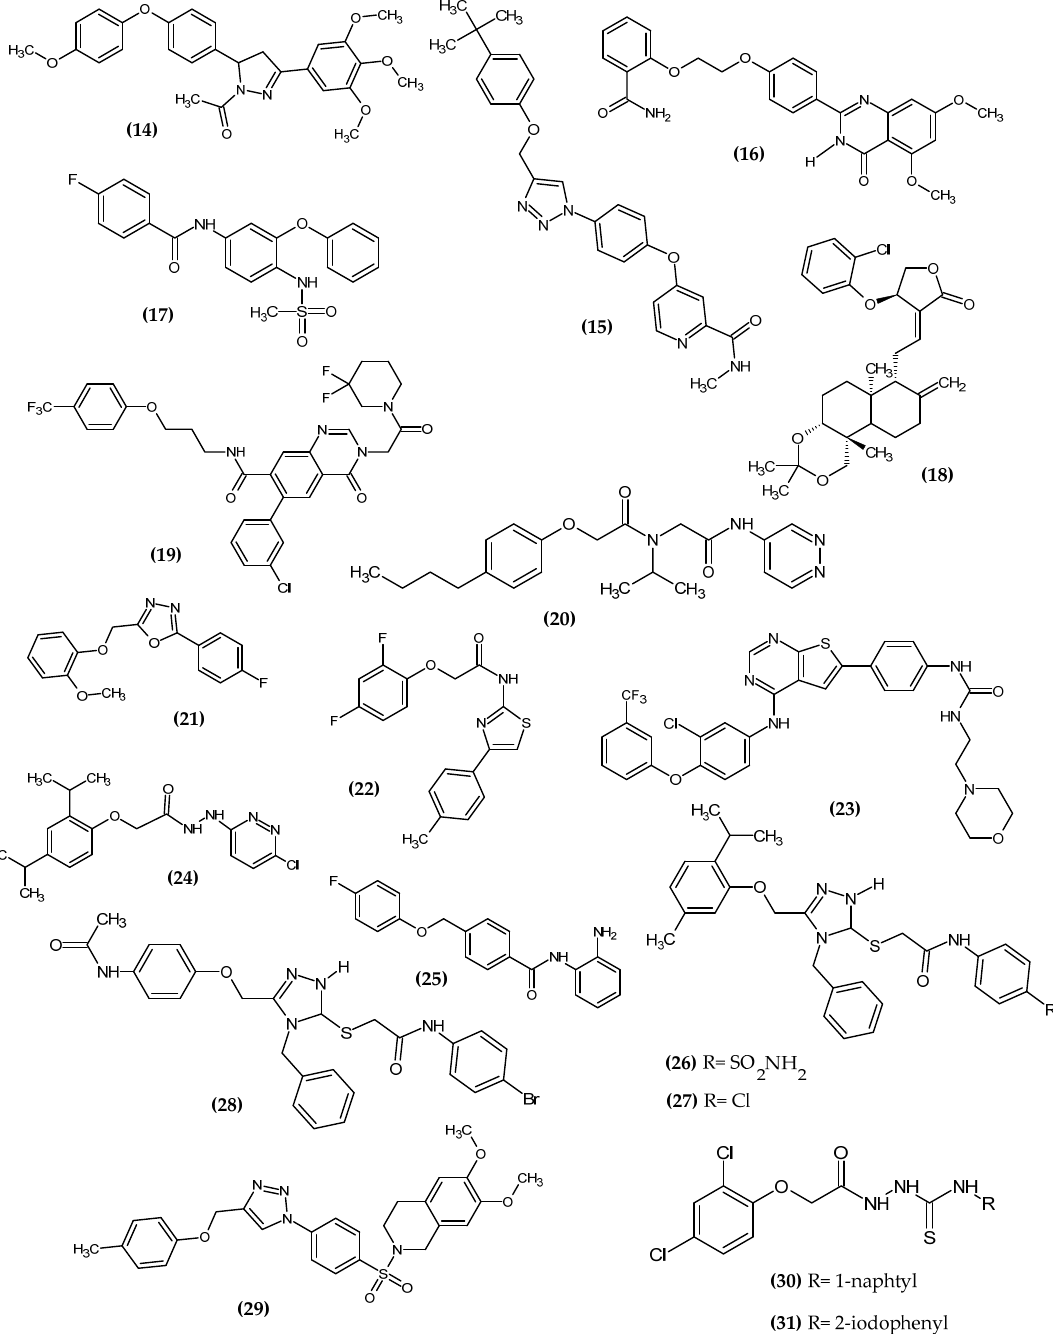
Figure 14. The novel potential agents with anticancer activity bearing a phenoxy group. Hassan et al. obtained a novel series of pyrazoline derivatives as antiproliferative agents by inhibiting the vascular endothelial growth factor receptor (VEGFR) pathway [54]. Stimulation of the Janus signaling (JAK) pathway and activators of transcriptional proteins 3 (STAT3) in neoplastic cells by hypoxia and inflammatory cytokines results in the secretion of proangiogenic proteins such as vascular endothelial growth factors (VEGF). It activates the phosphorylation of its receptors (VEGFR) in endothelial cells, which leads to the induction of angiogenesis [55–57]. Therefore, the search for new poten- tial agents against this signaling pathway allows for controlling tumor proliferation [58]. The basis of the design of the novel substances was the presence of the phenoxy moiety